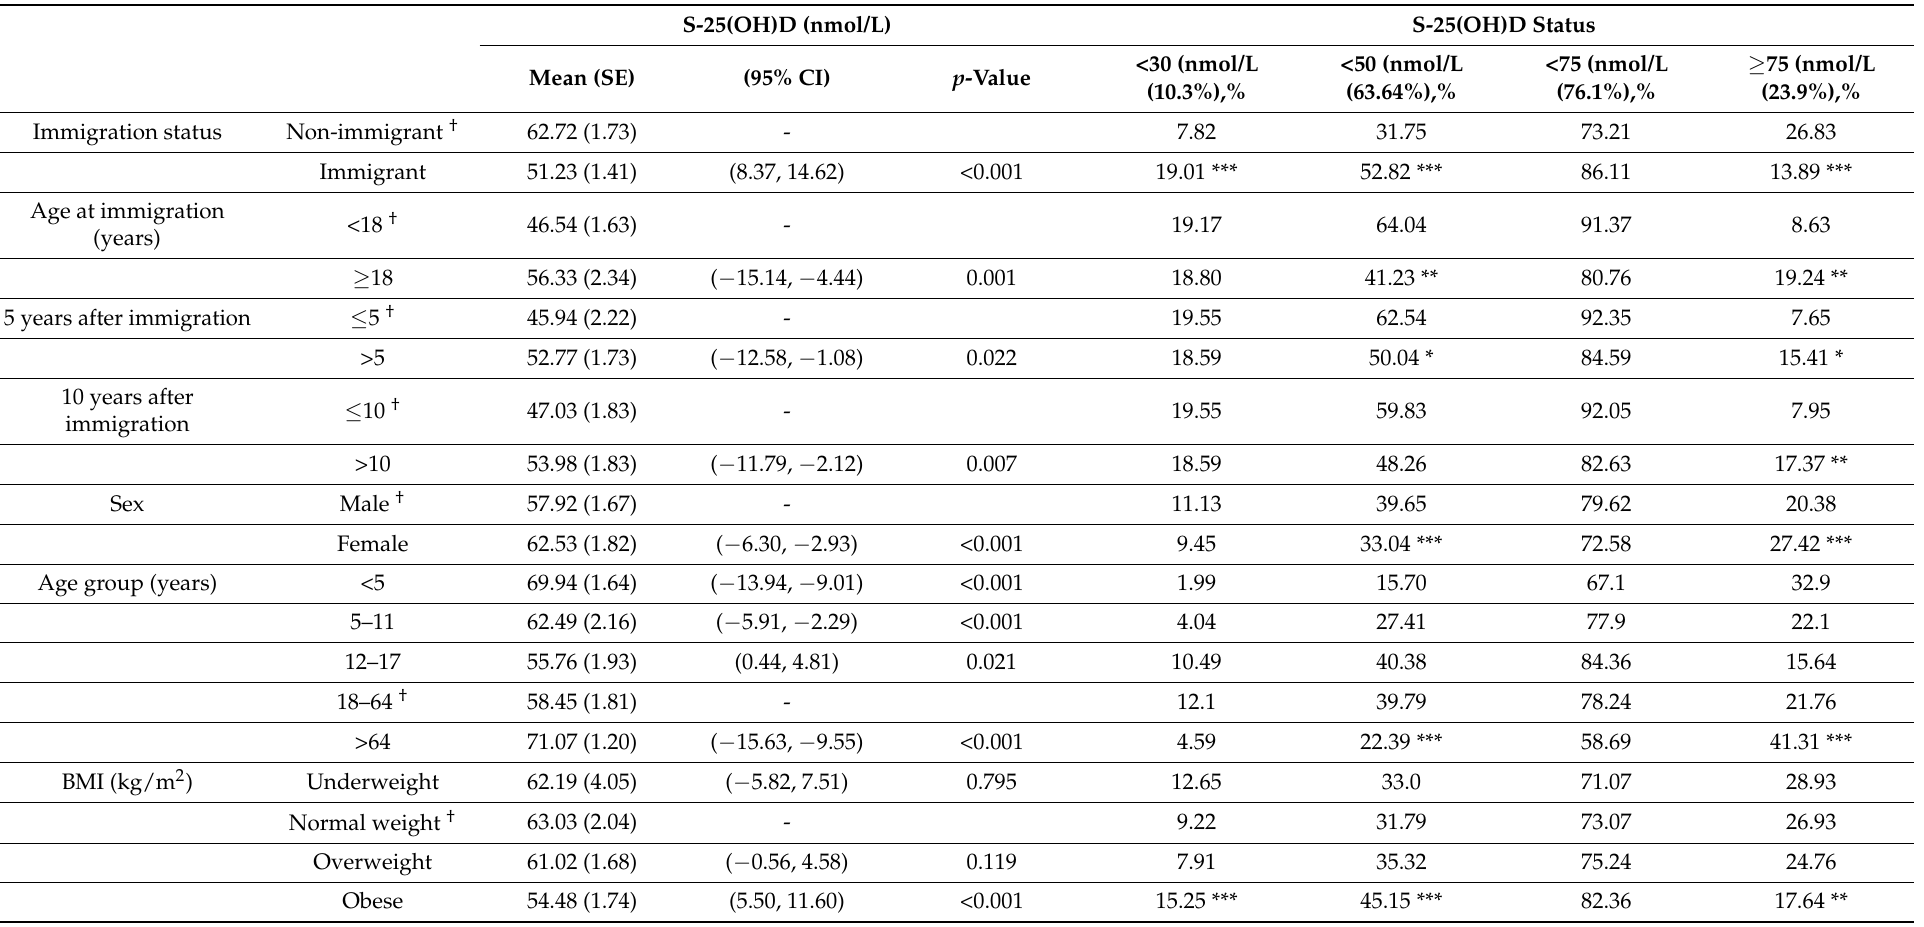
Table 2. Weighted mean S-25(OH)D (nmol/L) and vitamin D status by sociodemographic and lifestyle factors using Cycles 3 and 4 of Canadian Health Measures Survey